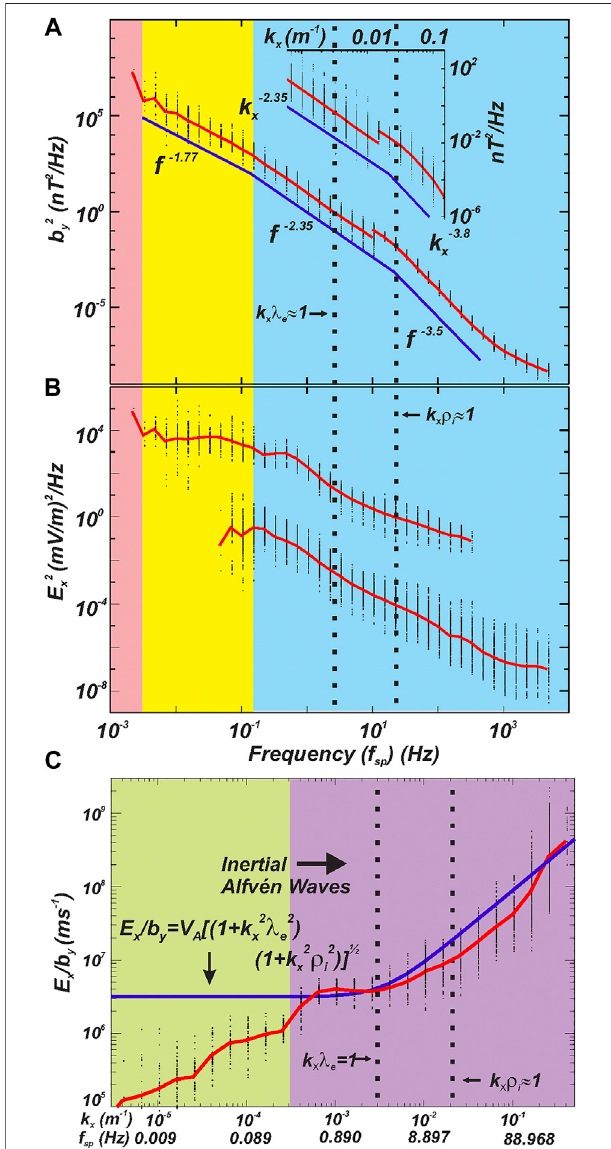
FIGURE 1 | Spectral statistics above “ Alfvenic ” aurora. (A) Average spectral energy density in magnetic fi eld variations ( b Y ) perpendicular to the geomagnetic fi eld as a function of frequency ( f sp ) measured in the spacecraft frame. The inset plot shows the same result but as a function of the wavenumbermeasured perpendiculartothegeomagnetic fi eld( k x ).Theoffset in these curves at ∼ 10 Hz is due to the transition from fl uxgate to search coil magnetometer measurements. The later are recorded only during intervals of enhanced auroral activity where spectral energy densities are larger leading to the offset. (B) Average spectral energy density in electric fi eld variations ( E x ) perpendicular to both the geomagnetic fi eld and the magnetic fi eld variations shown inpart (A) .Thetwocurves shown correspond tomeasurementsmade in survey and burst instrument modes with the burst mode data downshifted by 4 orders of magnitude for visibility. The black bars are composed of points representing individual measurements in each frequency bin. (C) Observed average value (red) of the ratio E x / b y as a function of perpendicular wavenumber ( k x ) and f sp . The blue line shows the ratio given by the dispersion relation for inertial Alfvén waves based on locally observed parameters [Modi fi ed from Chaston et al.